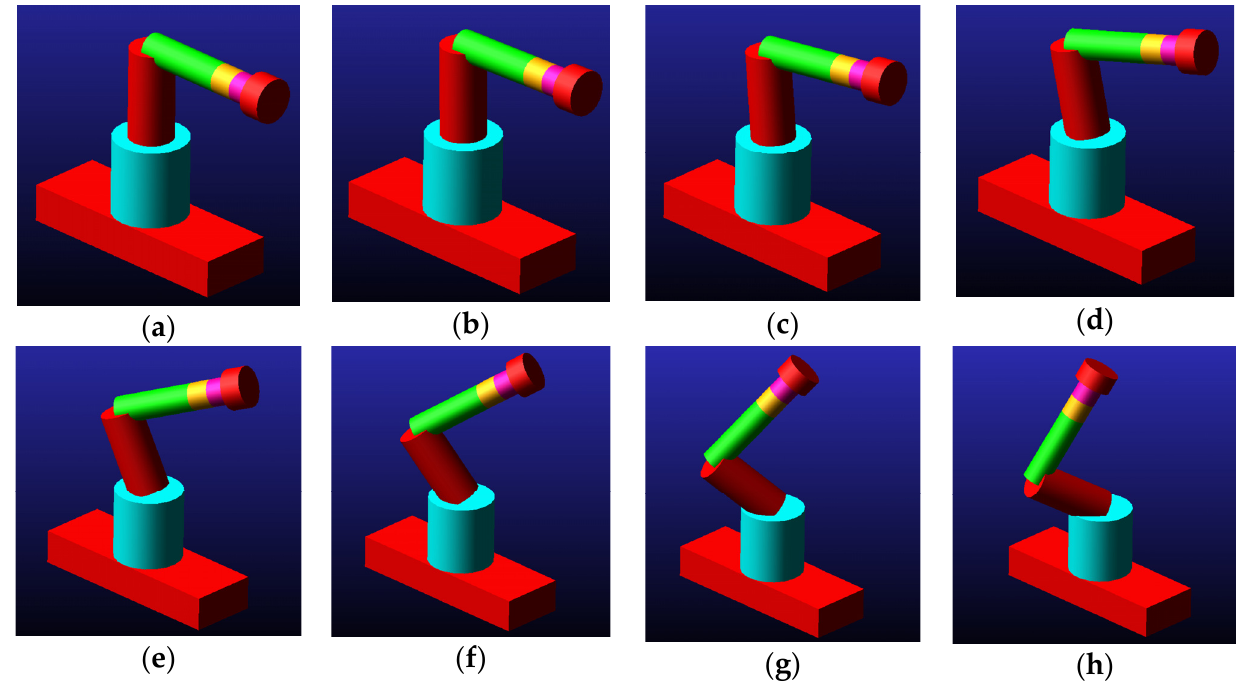
Figure 2. The poses at each time in the ADAMS simulation of the 6-DOF robot. ( a ) 0 s; ( b ) 0.3 s; ( c ) 0.6 s; ( d ) 0.9 s; ( e ) 1.2 s; ( f ) 1.5 s; ( g ) 1.8 s; ( h ) 2 s. The dynamic parameters are identified by Equation (27), and the results are shown in Table 2. Table 2. Identified dynamic parameters of robot. Rigid Body B